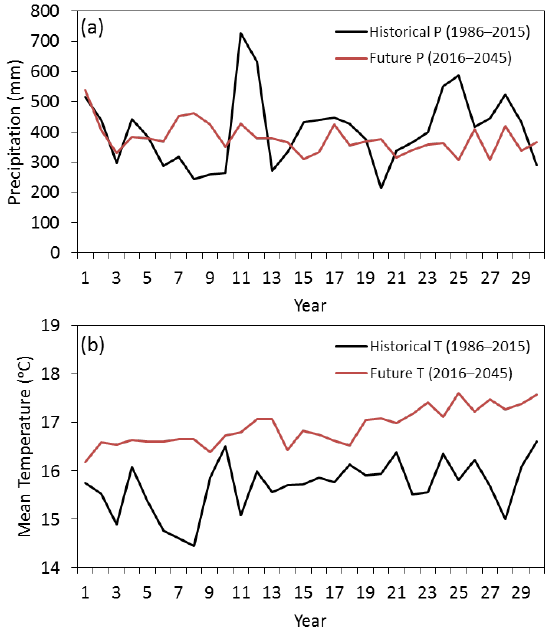
Figure 3. Yearly mean historical and generated future series of precipitation ( a ) and mean temperature ( b ) for the periods 1986–2015 and 2016–2045. The historical data were obtained from the Spain02 dataset and the future series was generated by applying the proposed methodology.